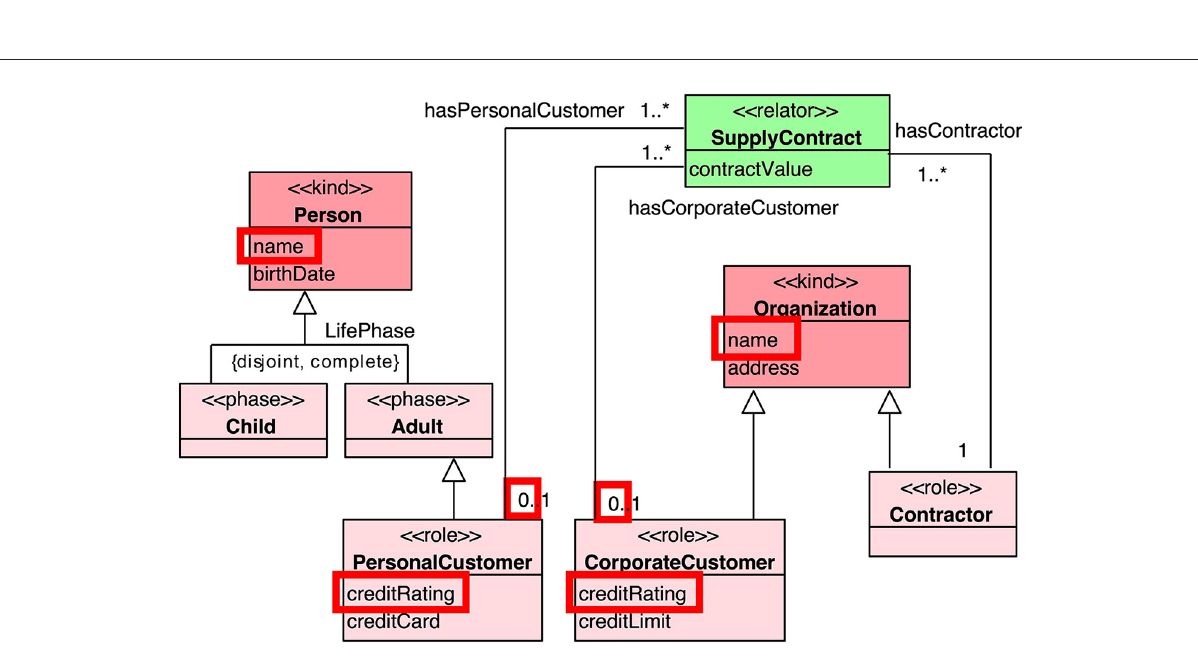
FIGURE4 Result of flattening NamedEntity and Customer